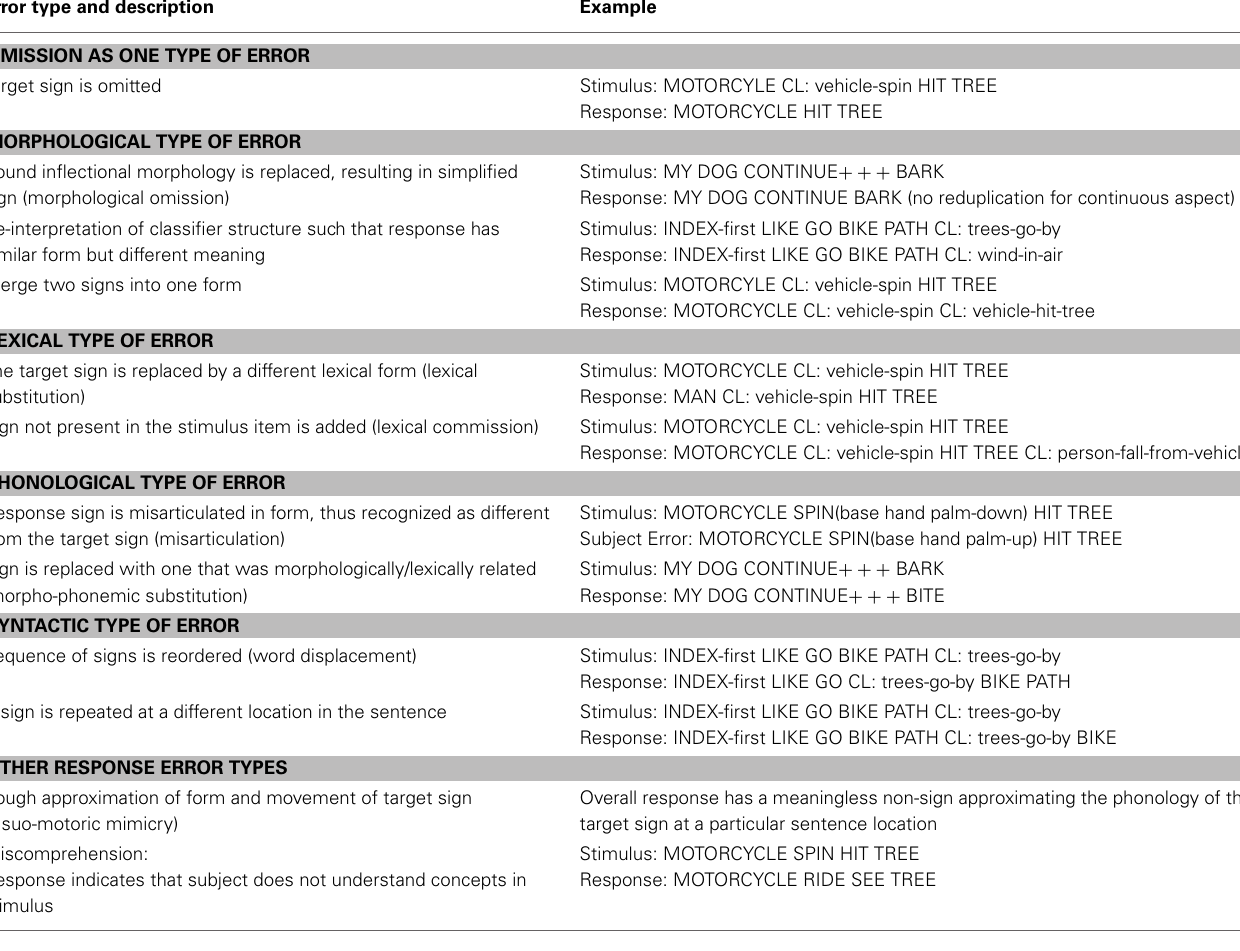
Table 3 | Classification of reproduction errors. Error type and description